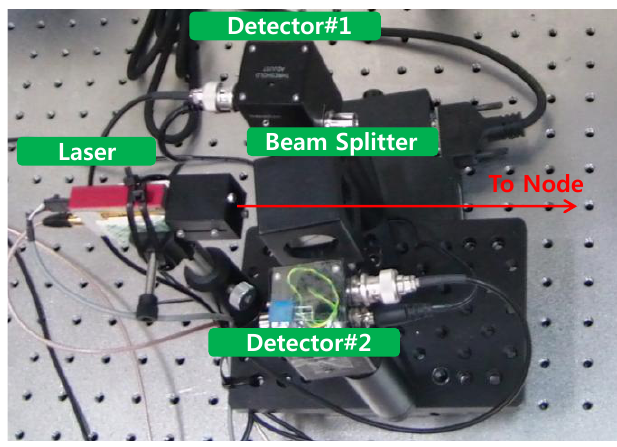
Figure 3. Implementation of the base station.